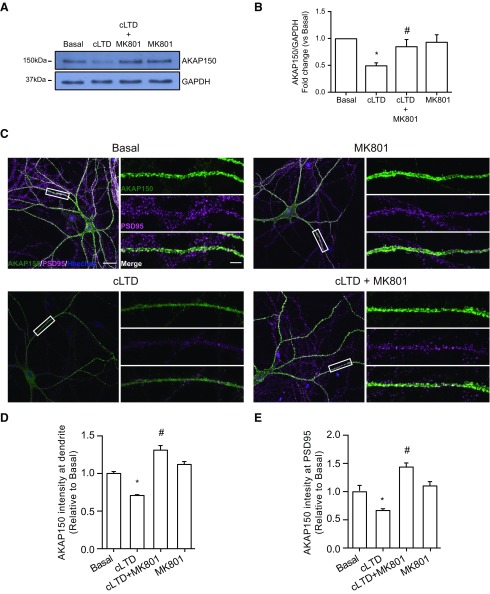
cLTD-mediated reduction of AKAP150 requires calcium influx through NMDA receptors. A, Representative blot images showing the effect of NMDAR antagonist MK801 (10 μM) on AKAP150 protein levels after cLTD (top panel) related to GAPDH (bottom panel) used as a loading control. B, Quantification of AKAP150 changes in response to NMDA stimulation in presence of MK801 compared with cLTD (n = 4, *p = 0.0036 vs basal and #p = 0.0395 vs cLTD). C, Representative confocal images of primary neurons showing AKAP150 (green), postsynaptic marker PSD95 (magenta) and nuclei (blue) staining. Separated color panels for individual marker from the boxed regions have been magnified for dendrite clarity (right panels). Lower right panels show the merge for AKAP150 (green)/PSD95 (magenta), where cLTD reduced dendritic and synaptic intensity in AKAP150 staining. The presence of MK801 (10 μM) blocks this reduction. D, Quantification of AKAP150 intensity at dendrites. cLTD reduced AKAP150 dendritic intensity and the presence of MK801 avoids this reduction (n > 15 dendrites of different neurons from four independent cultures, *p < 0.0001 vs basal; #p < 0.0001 vs cLTD). E, Quantification of AKAP150 intensity at the PSD95. cLTD reduction of synaptic AKAP150 intensity was blocked by MK801 (n > 50 puncta from >15 dendrites from four independent cultures, *p = 0.0150 vs basal; #p < 0.0001 vs cLTD). Scale bars = 20 μm (C, left panels) and 5 μm (C, right panels). Bars represent mean ± SEM.